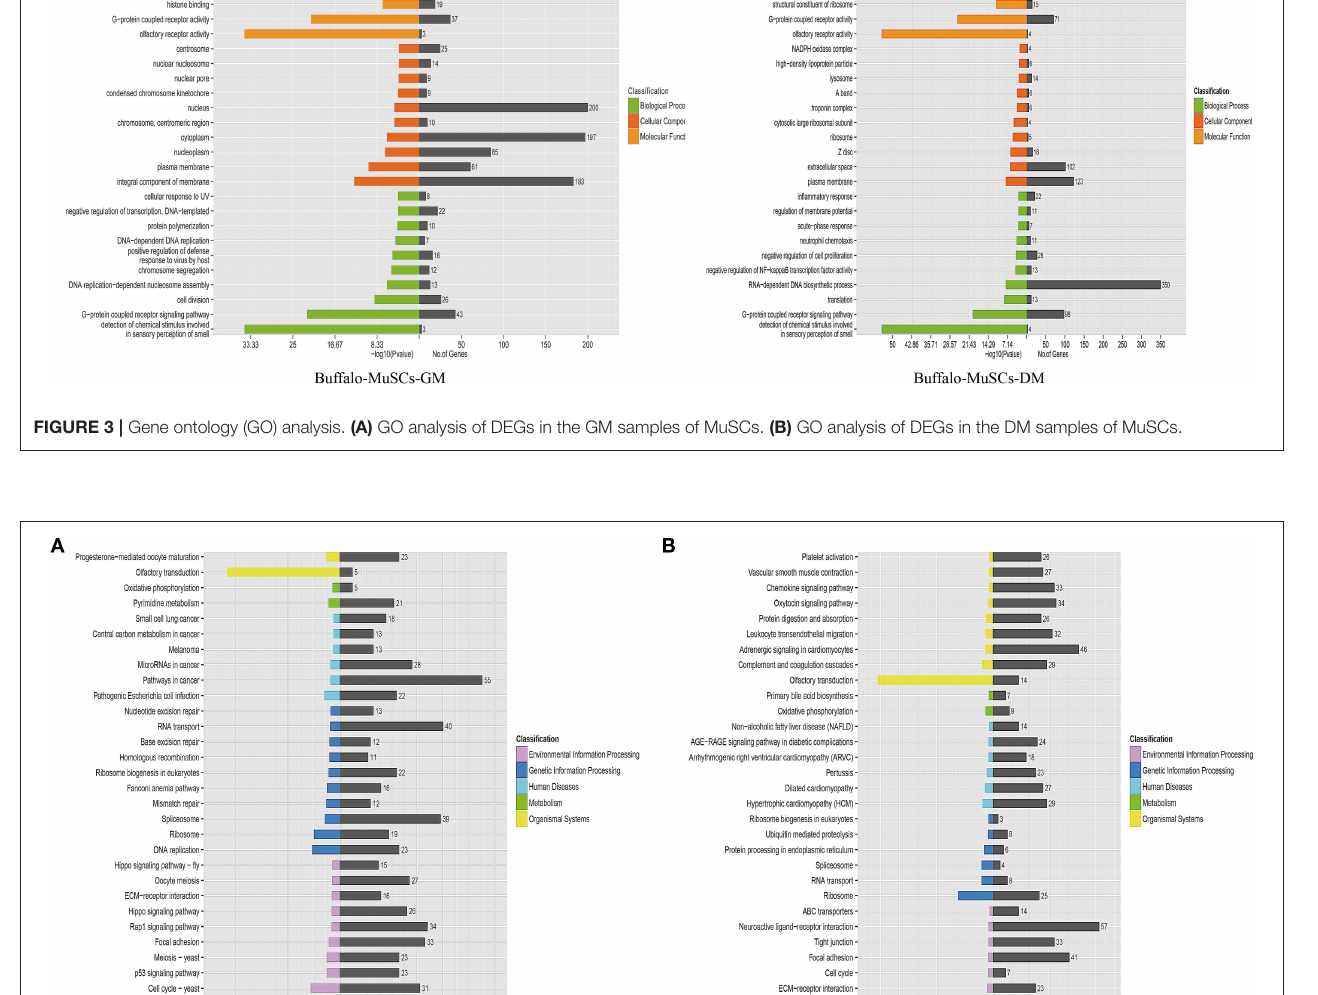
cyclin D1 ) related to the cell cycle, actin cytoskeleton, cell differentiation, and lipid metabolism ( Figures 5A,B ), and